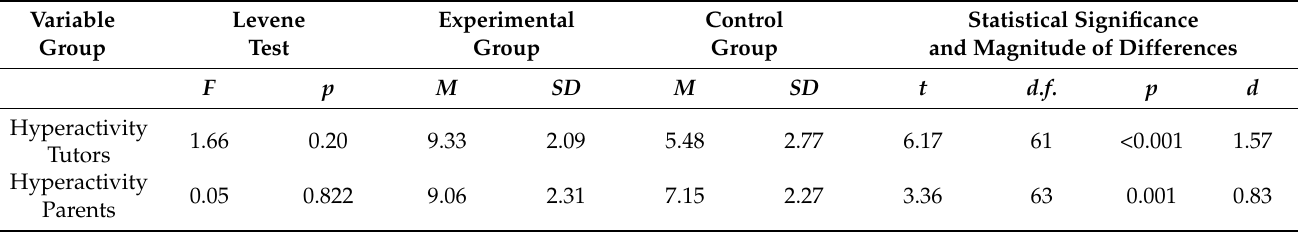
Table 2. Score differences for the hyperactivity subscale of the Strengths and Difficulties Questionnaire (SDQ) (teachers and parents version) between the control group and experimental group.